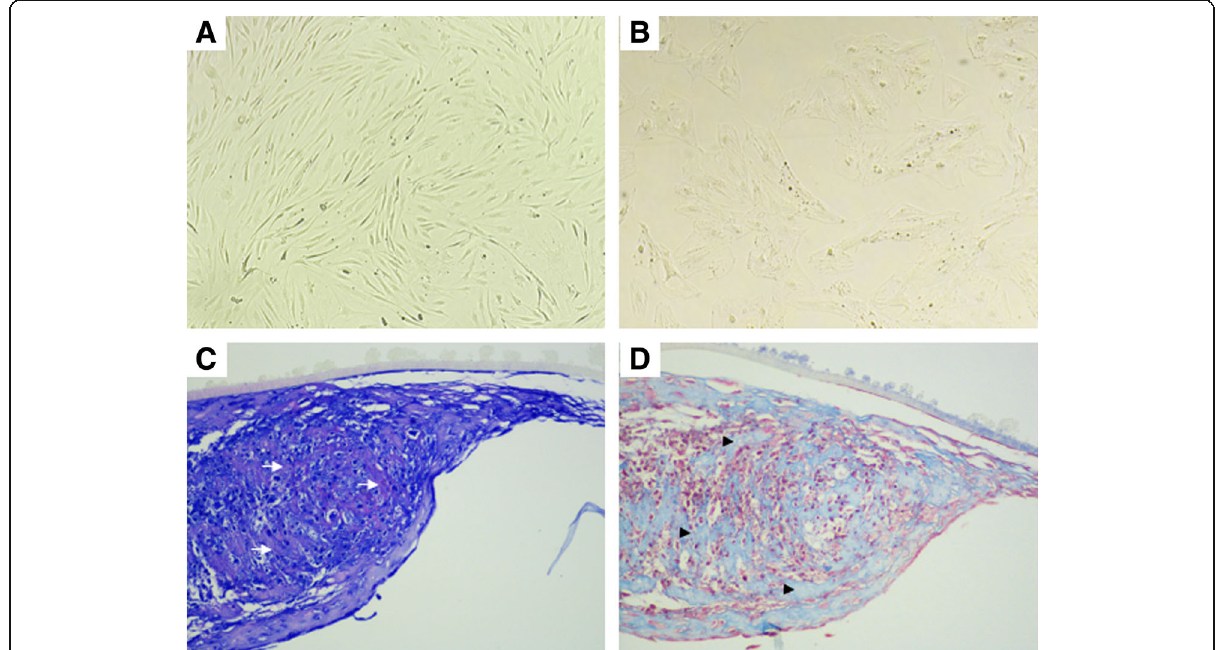
Fig. 1 Chondrogenic differentiation of human MSC. Cellular morphology changes were evident in human MSC ( a) prior to, and ( b ) following culture in chondrogenic differentiation media for 7 days, with the transformation of spindle-shaped MSC to rounded, polygonal chondrocytes (magnification, 10x). Chondrogenic differentiation was confirmed histologically, with chondrocyte aggregation and early structural organisation of a collagenous matrix evident. Representative formalin-fixed, paraffin-embedded sections of chondro-MSC were stained with ( c ) toluidine blue to demonstrate sulphated glycosaminoglycans deposition (white arrow) or ( d ) Picro-Mallory trichrome stain highlighting deposition of collagen fibres (black arrowhead) within the extracellular matrix (magnification,